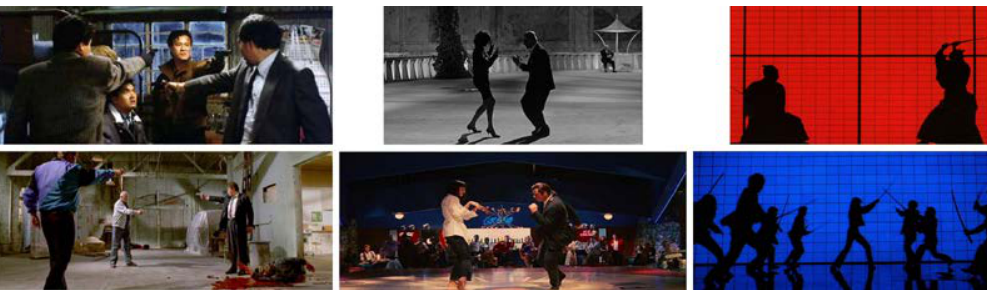
Fig. 6 Ringo Lam, City on Fire , 1987 (top left); Federico Fellini, 8 ½ , 1963 (top center); Hiroyuki (top right). Quentin Tarantino, Reservoir Dogs , 1992 (bottom left), Pulp Fiction , 1994 (bottom centre), Kill Bill , 2003 (bottom